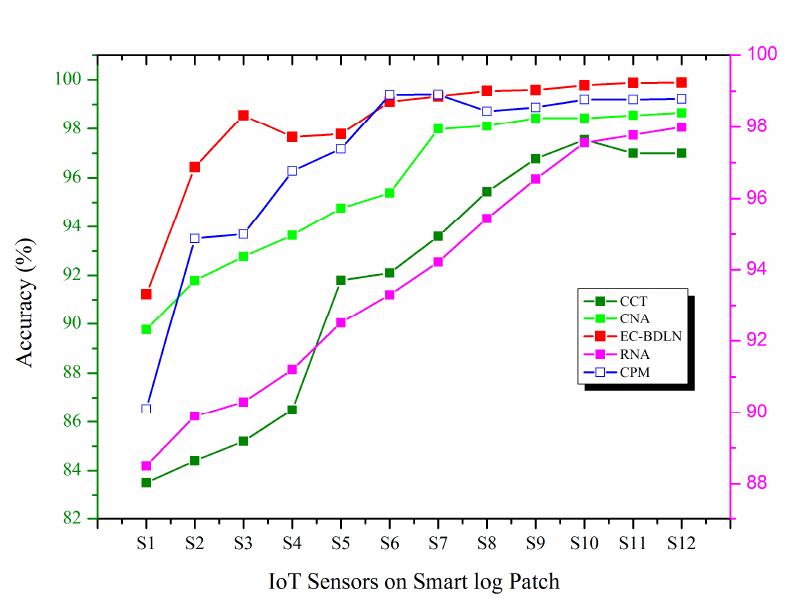
Figure 6. Accuracy factor of IoT sensor.